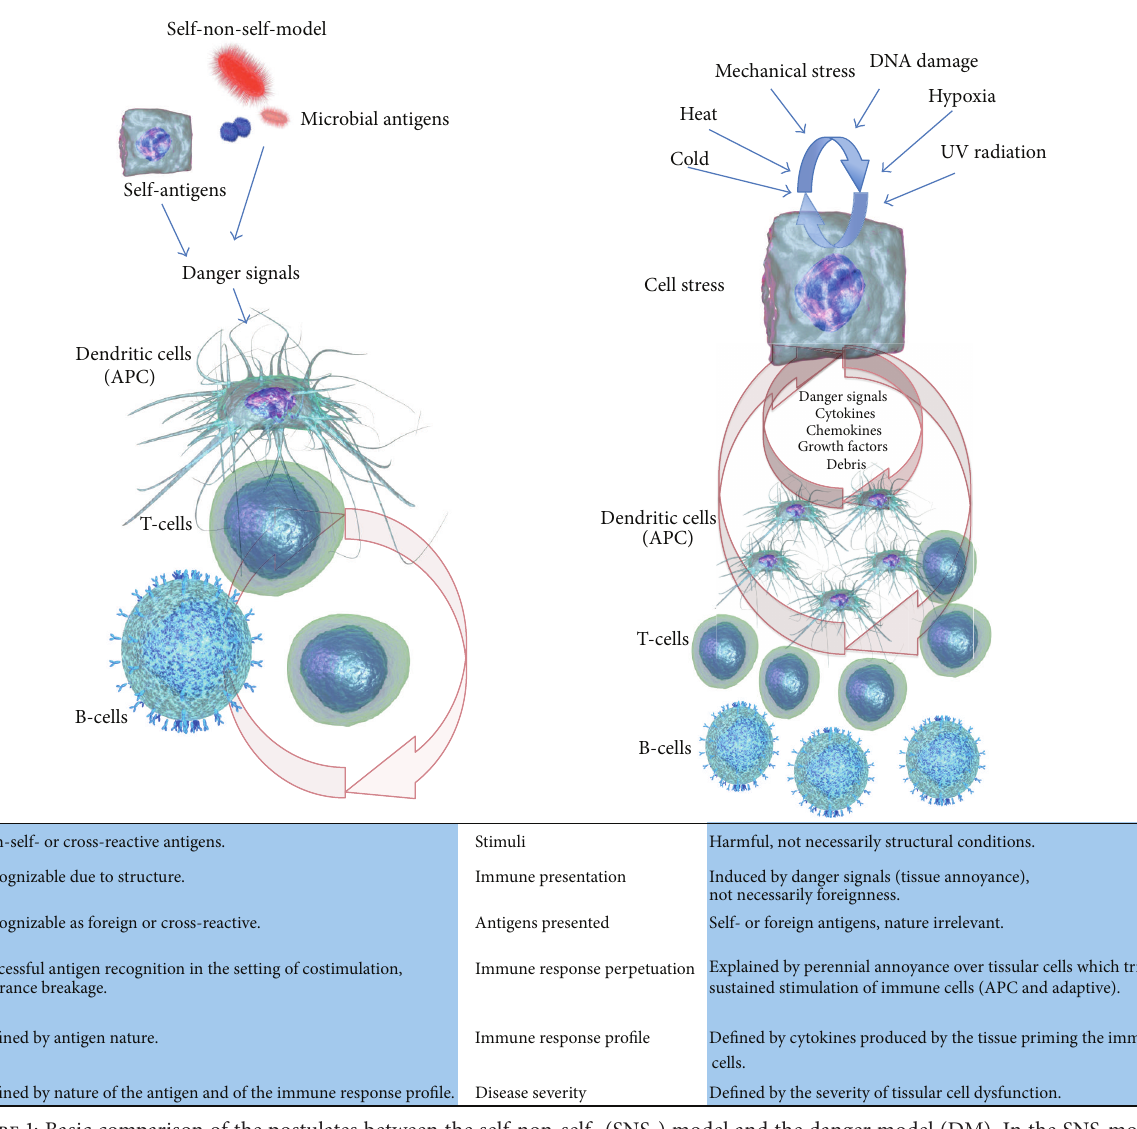
Figure 1: Basic comparison of the postulates between the self-non-self- (SNS-) model and the danger model (DM). In the SNS-mode, the triggering stimulus is the antigen which is by definition foreign, or, if endogenous, it is mistaken as foreign; once the antigen specific cells have been primed, the persistence of the immune response depends on the perpetual presence of an antigen and for the case of an autoantigen on its expression where it can be detected and processed by antigen presenting cells to T-cells; the severity of the immune reactions depends on the nature and amount of the antigen and the type of immune response it settles on. In the case of the DM the initial step is a scenario of disturbance within the tissues which can be explained by both biological or physical aggressions, the disturbed tissular cell signals to the local antigen presenting cells, and, as the aggression becomes more chronic the tissular cell communicates directly to T- or B-cells; the perpetuating cycle for the case of chronic autoimmune diseases relies on the repeated disturbance of the tissular cells by the annoying stimuli and self- proteins are recognized eventually as antigens due to the enhanced antigenic presentation costimulation upregulated by the soluble factors released by the stressed tissular cells. The severity of the immune reaction depends on the intensity and frequency of the disturbance that the stimuli infringe in the tissular